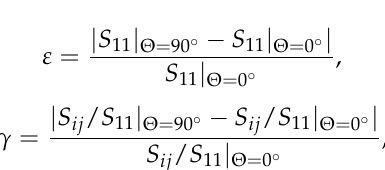
Equation (3) represents the relative error of S 11 , and Equation (4) represents the relative errors of S 12 / S 11 , S 33 / S 11 , and S 34 / S 11 . It can be seen from Figure 9 that the relative